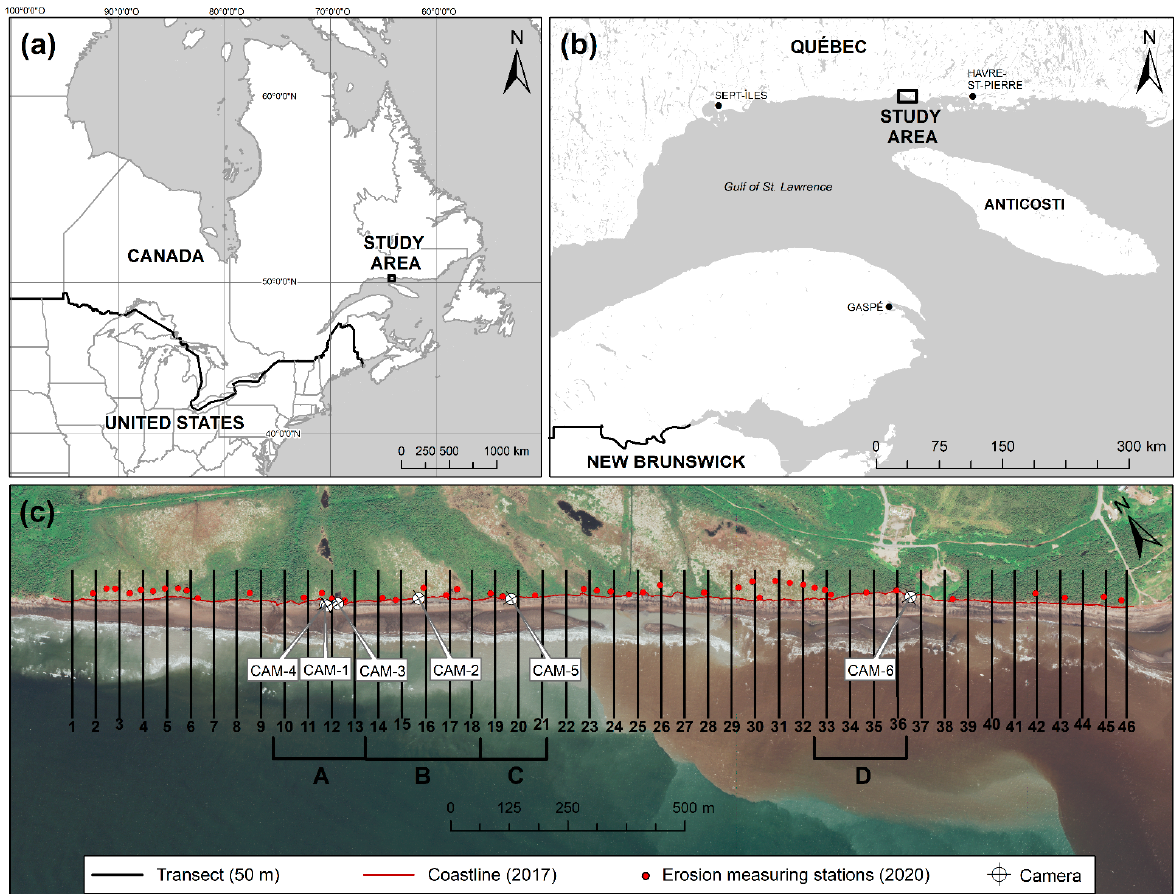
Figure 1. Location of study site. ( a ) General location; ( b ) Regional location; ( c ) Location of the study area, the four zones, transects, erosion stations and cameras.